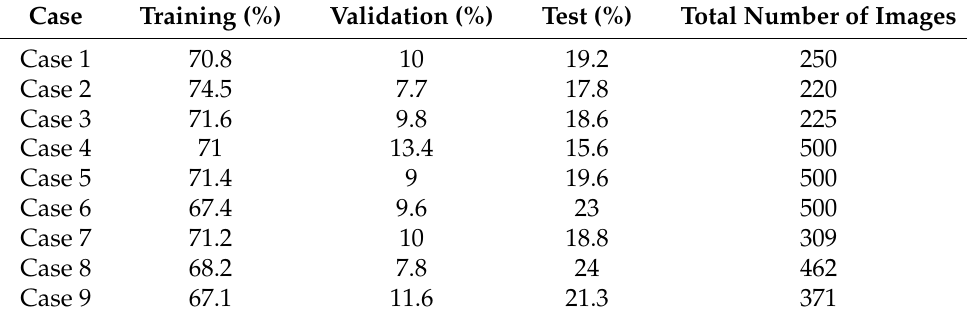
Table 2. The Number of Input Image Data Used for Training, Validation, and Test.